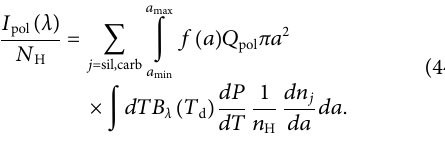
FIGURE 6 (A) Schematic illustration of the model. A molecular cloud is irradiated by the central star, so that the radiation strength decreases from U 0 to U ISRF . The colorgradient indicatestheincrease ofthegas density from thecentral star. Magnetic polarization degree vs. radiation strength (dust temperature) at 850 μ m predicted by the numerical model (Lee et al., 2020). If we consider only the RAT-Aeffect,thepolarizationdegreemonotonicallyincreaseswithincreasingtheradiationstrength(dusttemperature)asexpected(blackline). Ifwe take into account the RAT-D mechanism, rotational disruption occurs when theradiationstrength(dust temperature) is suf fi ciently high. Once this happens, the depletion of largest grains results in the decrease of the polarization degree (color lines). Figure taken from Lee et al. (2020) and Tram et al.